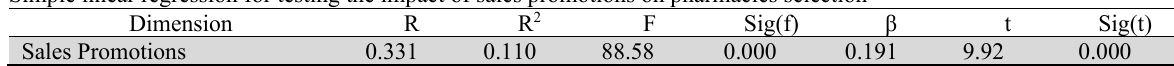
Simple linear regression for testing the impact of sales promotions on pharmacies selection Dimension